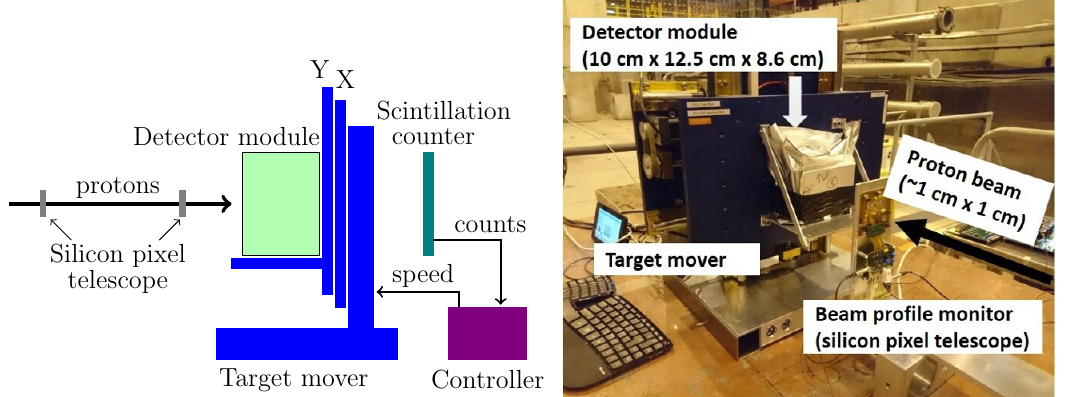
Figure 10 . Left: a schematic of DsTau setup. Right: photo of the detector setup for the test beam campaign at the CERN SPS H4 beamline. The detector module was driven by a target mover so that it was uniformly exposed to the proton beam at a density of 10 5 protons/cm 2 .